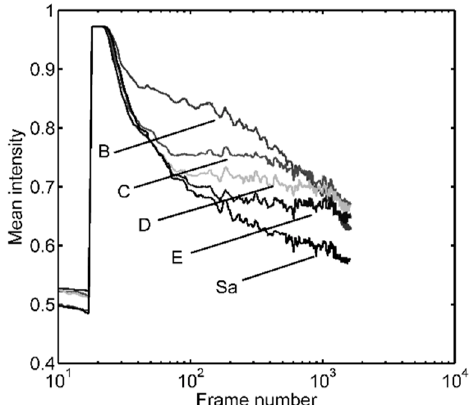
Figure 3. Change in mathematical expectation of pixel intensity within the areas denoted by B, C, D, E and Sa in Figure 2.